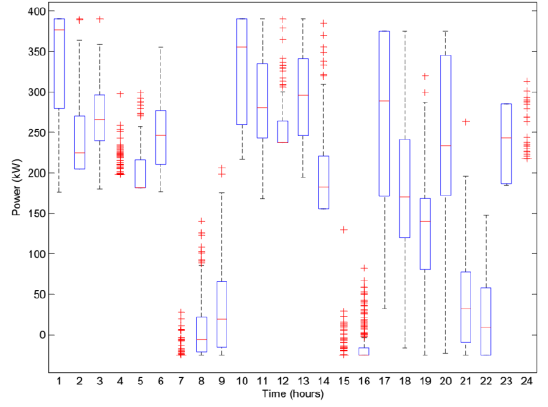
Figure 11. Case 2 results: ( a ) optimal daily schedule for the DGs and ( b ) box plots of wind power and ESS power, DG power, and forecasted demand.